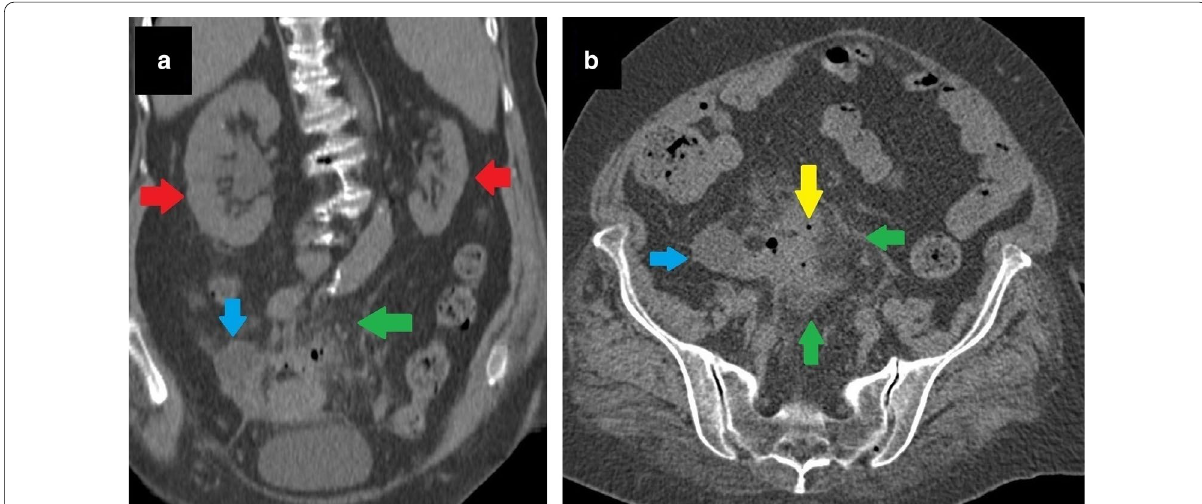
Fig. 17 Framing bias causing an under-reading error. A 77-year-old female patient with a history of renal stone and recurrent urinary tract infections presented with lower abdominal pain. The patient’s symptoms did not regress under proper antibiotherapy. Non-enhanced CT was ordered for “evaluation of renal stones and urinary pathologies.” The CT was reported as “normal, except left atrophic kidney (red arrows, a ).” However, a collection (blue arrows, a , b ), free-air bubbles (yellow arrow, b ) and mesenteric fat stranding (green arrows, a , b ) adjacent to the sigmoid colon were overlooked due to the framing of clinical information. Although non-enhanced CT was technically inadequate to evaluate bowel pathologies, inflammatory changes were clearly visible on CT, and at least a suspicion should have been expressed. During follow-up, lower abdominal MRI revealed the final diagnosis as “perforated sigmoid colon malignancy” (not